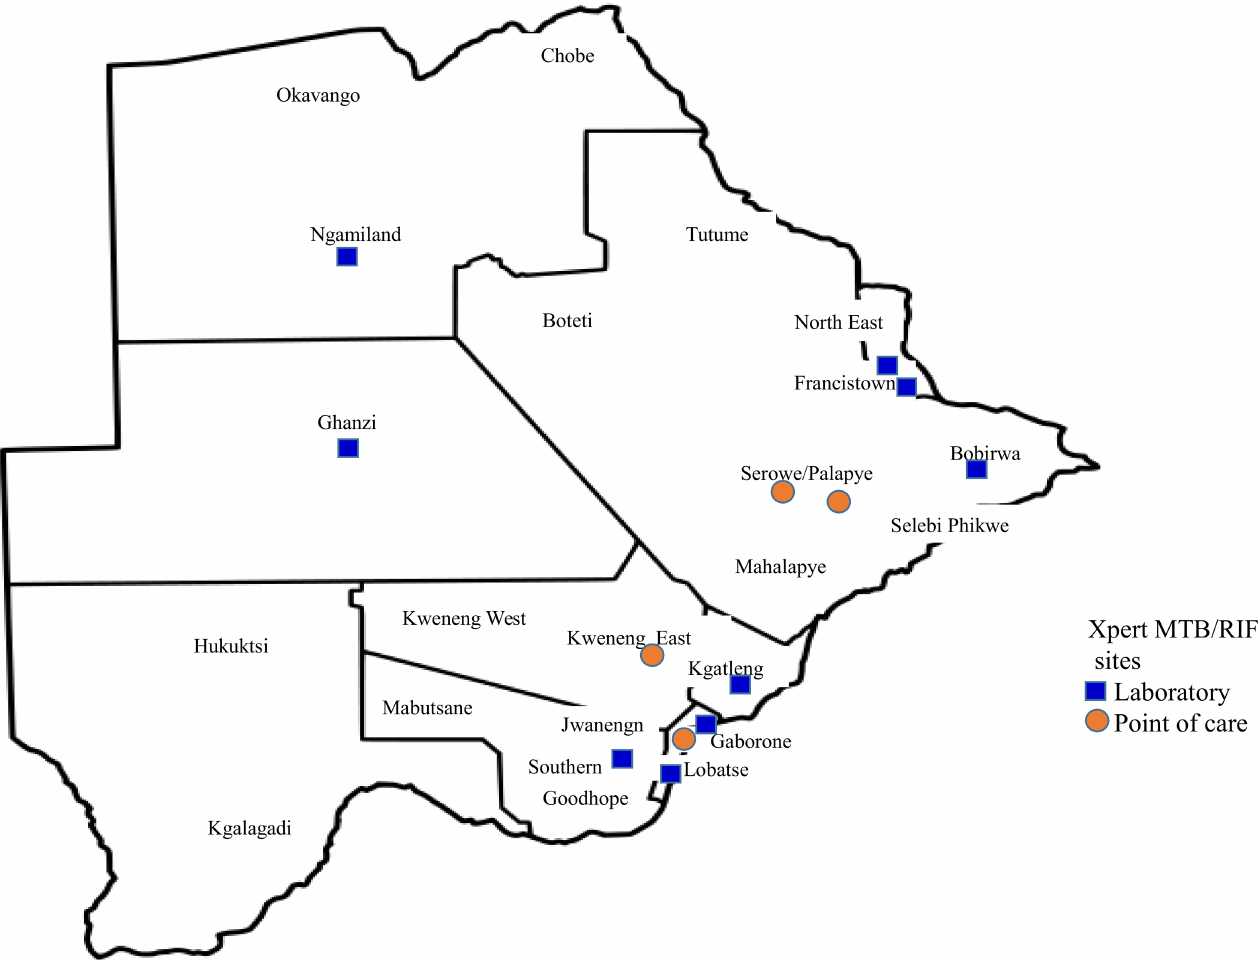
Fig 1. Thirteen GeneXpert instruments sites in